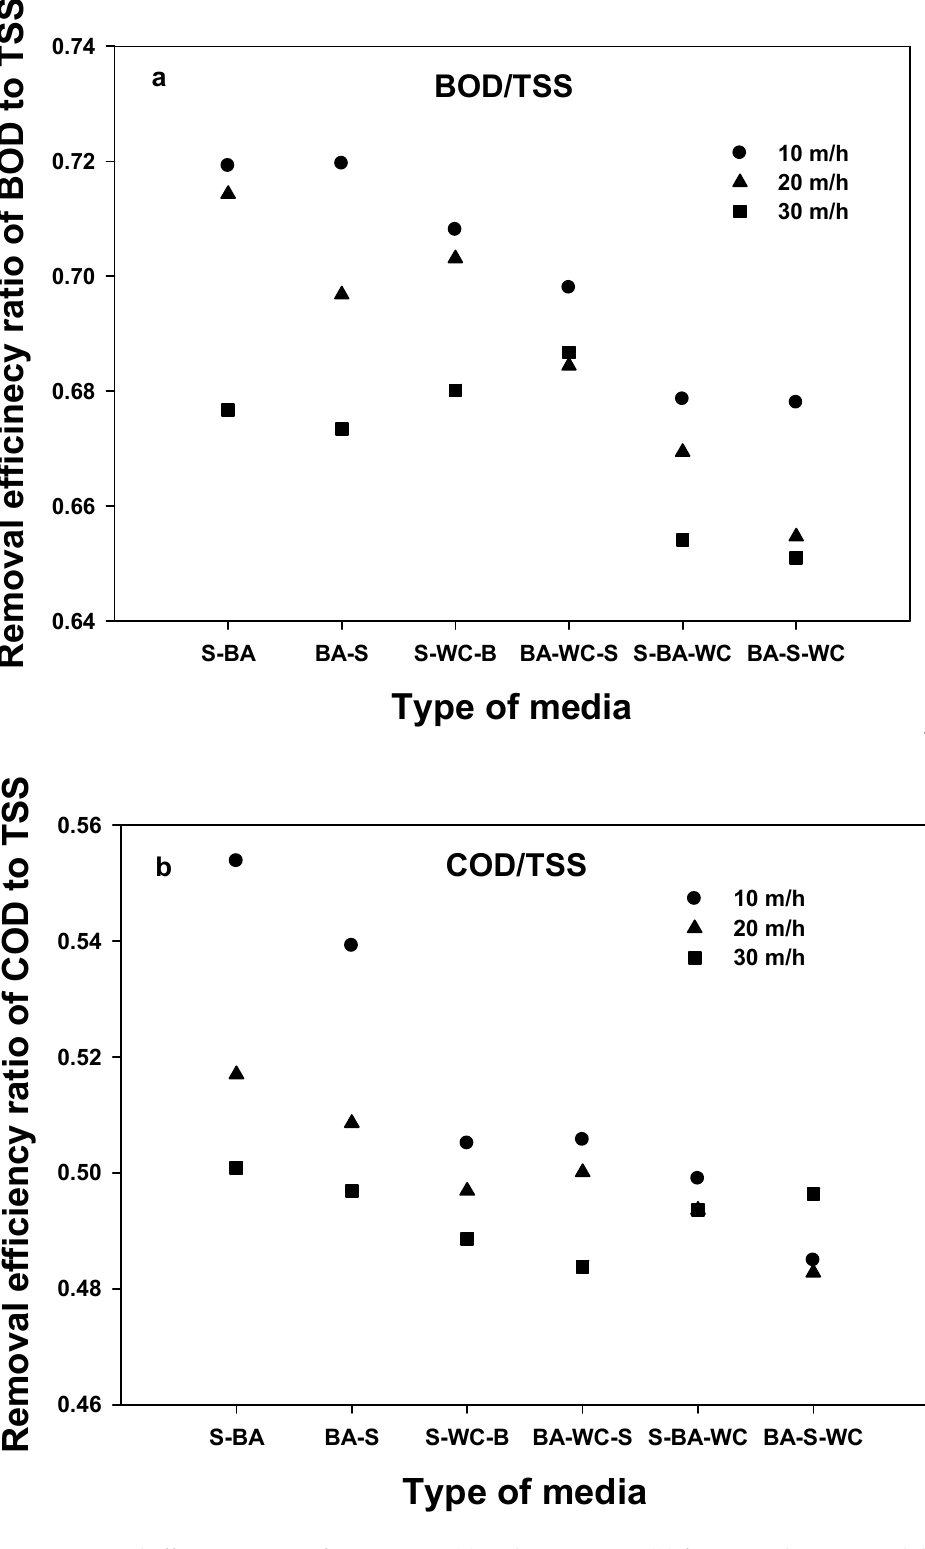
Figure 4. Removal efficiency ratios of BOD to TSS ( a ) and COD to TSS ( b ) for six media types and three different HCs (10, 20, and 30 m/h).